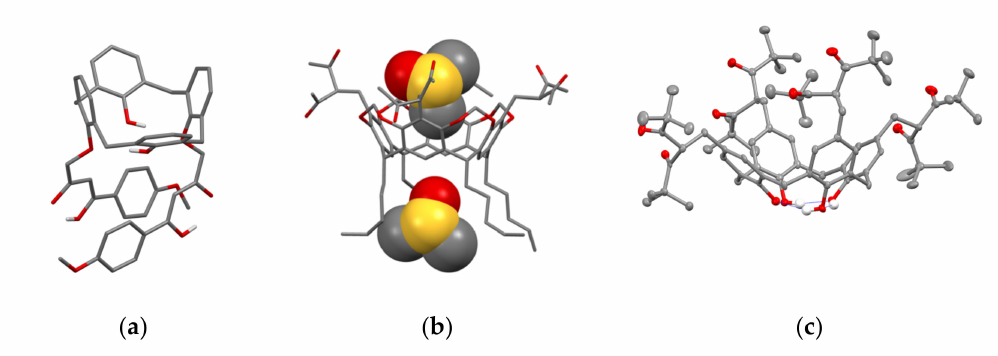
Figure 1. The molecules 19e ( a ), 26 ( b )and 27b ( c ) in the crystal. Molecule of 26 ( b ) with two DMSO molecules is represented in space-filled model. Hydrogen atoms are omitted for clarity. Redrawn from reference [49] ( a ). Reproduced from Ref. [53] ( b ) and [58] ( c ) with permission from the Centre National de la Recherche Scientifique (CNRS), the Royal Society of Chemistry and the Elsevier,